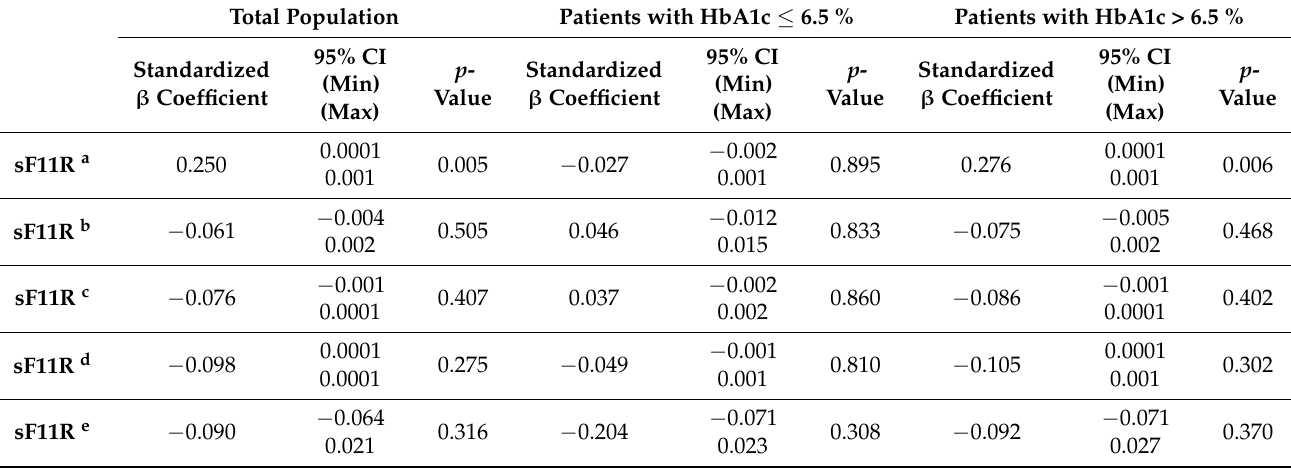
Table 3. Univariate analysis of association between plasma sF11R, ANXA5 levels, and vascular outcome. Total Population Patients with HbA1c ≤ 6.5 % Patients with HbA1c > 6.5